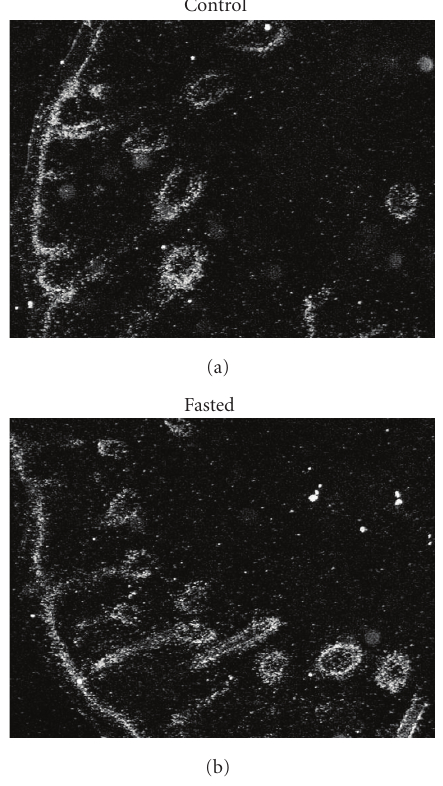
Figure 8: Representative images of AQP3 mRNA insitu hybridiza- tion, in skin of 1-day-old rat pups at the end of an 18-h period of fasting (fasted; n = 6) and in skin of suckling controls ( n = 6). The analysis reveals no changes in mRNA